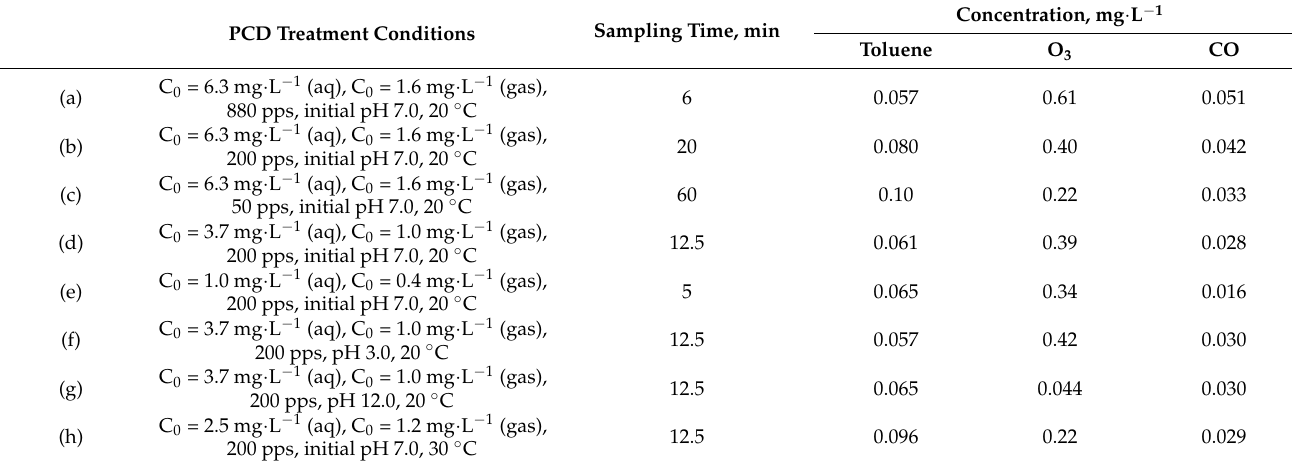
Table 2. Toluene, O 3 , and CO concentrations in PCD outlet gas.